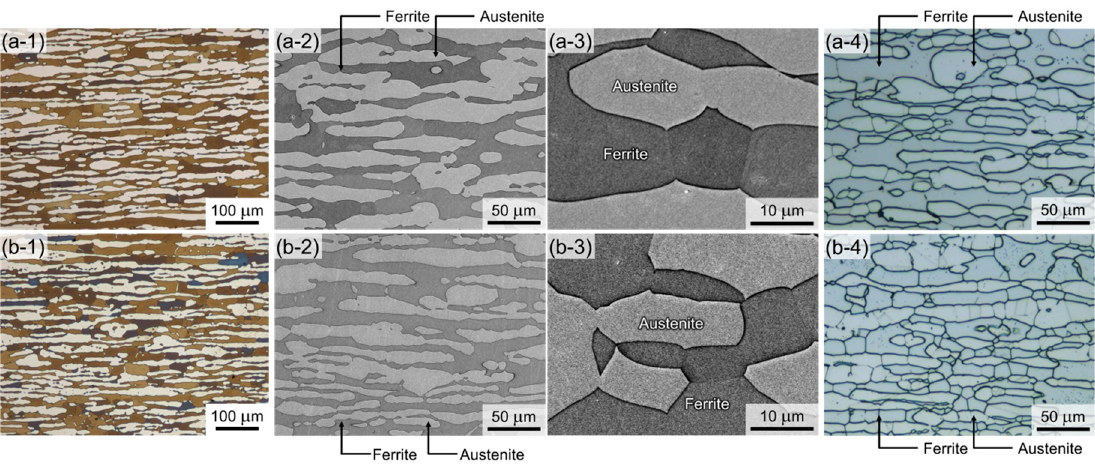
Figure 2. Microstructures of the ( a ) DSS-N and ( b ) DSS-NC: ( a -1, b -1) Light optical micrographs and SEM micrographs taken at ( a -2, b -2) low and ( a -3, b -3) high magnifications of the specimens etched in a mixed acid solution (20 ml HNO 3 + 30 ml HCl + 50 ml deionized water). ( a -4, b -4) Light optical micrographs of the specimens etched in a 40% HNO 3 solution by applying 4.5 V.